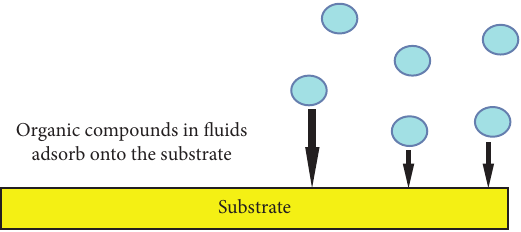
Figure 7: The substrate is the metal or the metal oxide which adsorbs the organic compound into their surface. A self-assembled monolayer is formed due to this interaction.